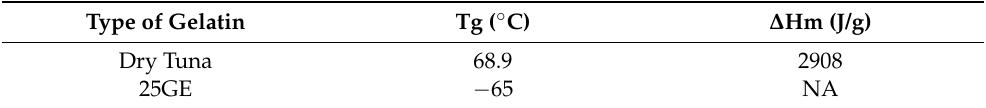
Table 7. Glass transition temperature (Tg), and enthalpy of melting ( Δ Hm) of Dry GE and 25GE in the Non Reversing thermogram (MDSC).